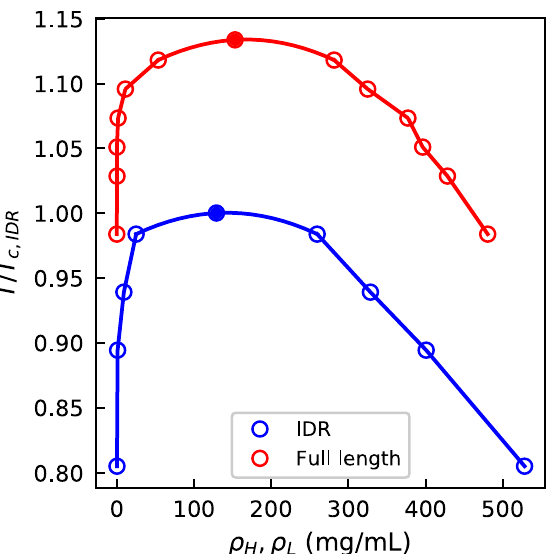
Fig 6. Phase diagram of IDR (blue) and full length (red) LAF-1. Temperatures are scaled by the critical temperature of IDR LAF-1. The corresponding slab density profiles are provided in S15